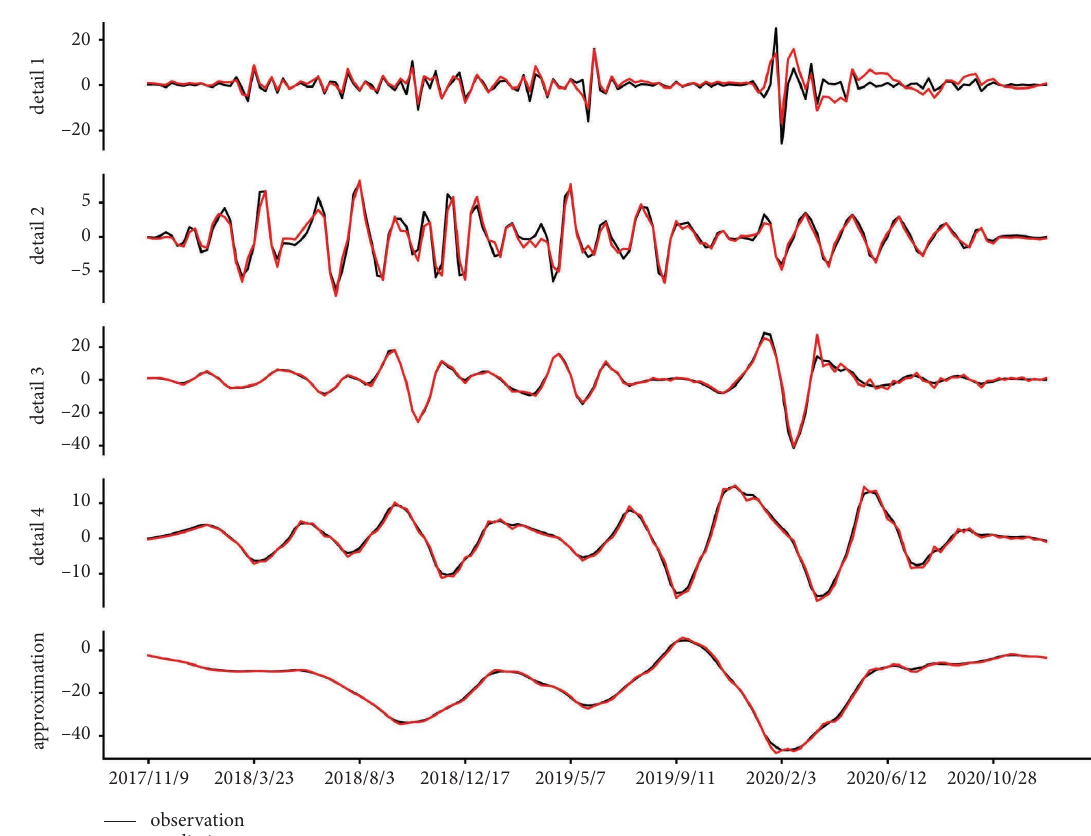
Figure 7: Te forecasting result of decomposed sequences (FR